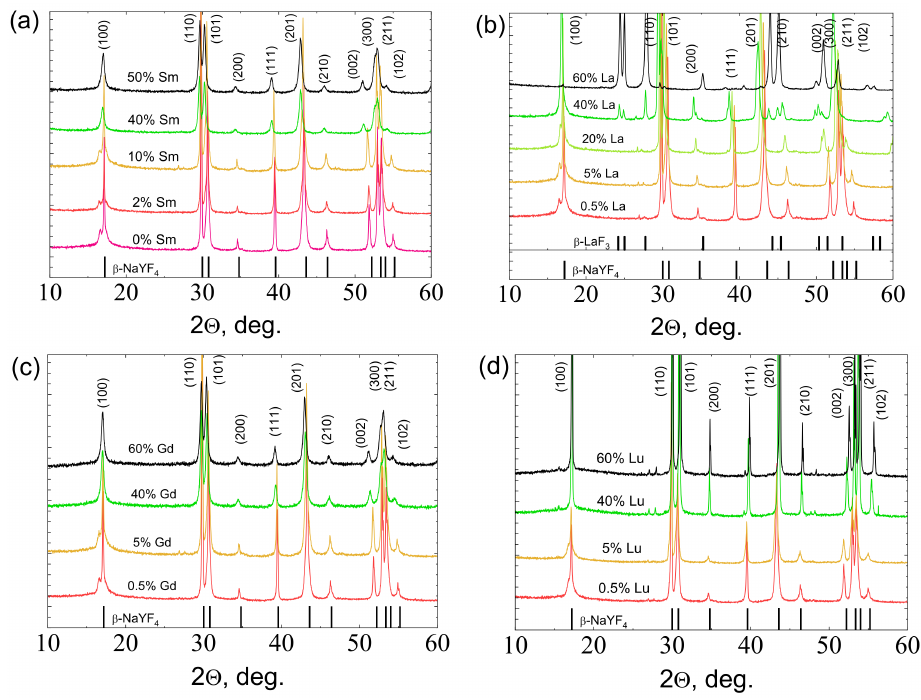
Figure 1. PXRD patterns of ( a ) NaY 1 − x Sm x F 4 , ( b ) NaY 0.98 − x Sm 0.02 La x F 4 , ( c ) NaY 0.98 − x Sm 0.02 Gd x F 4 , and ( d ) NaY 0.98 − x Sm 0.02 Lu x F 4 .